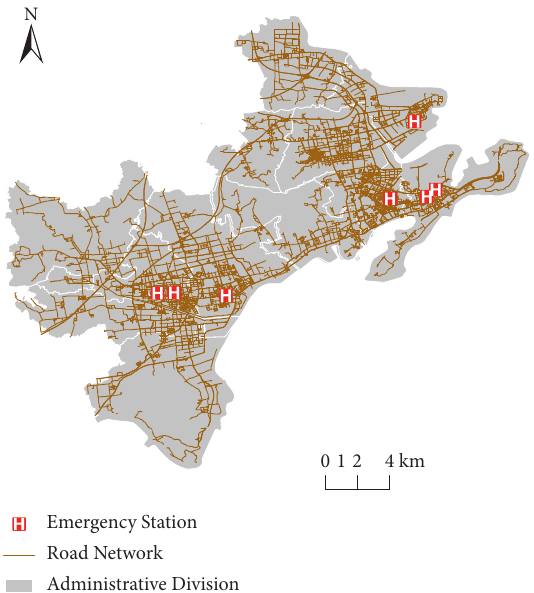
Figure 3: A distribution map of traffic networks and emergency